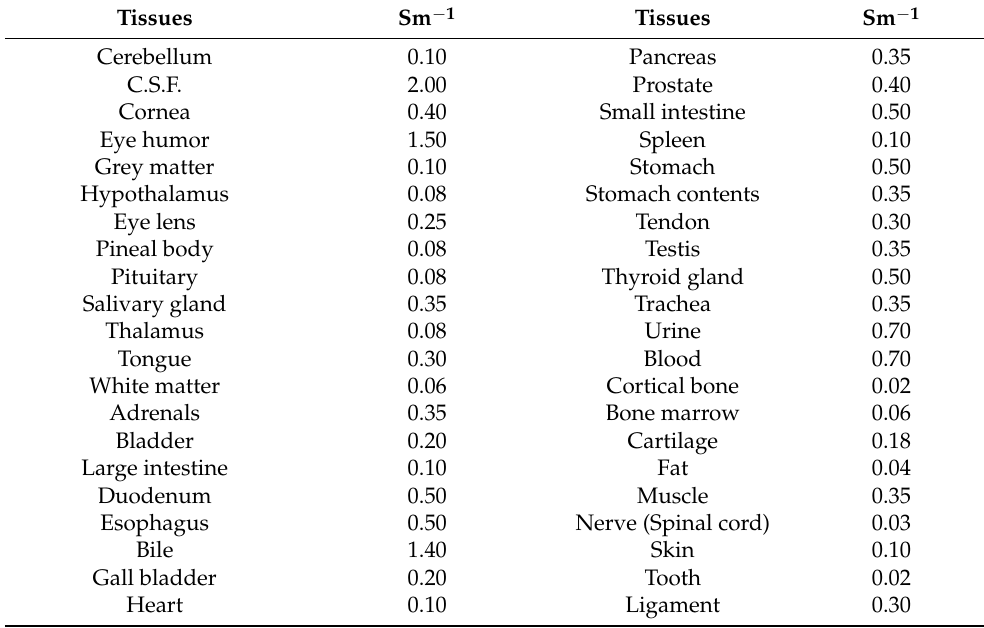
Table 3. Conductivity of human tissue (Siemens per meter (Sm − 1 ); copied from Reference [85]. Tissues Sm −